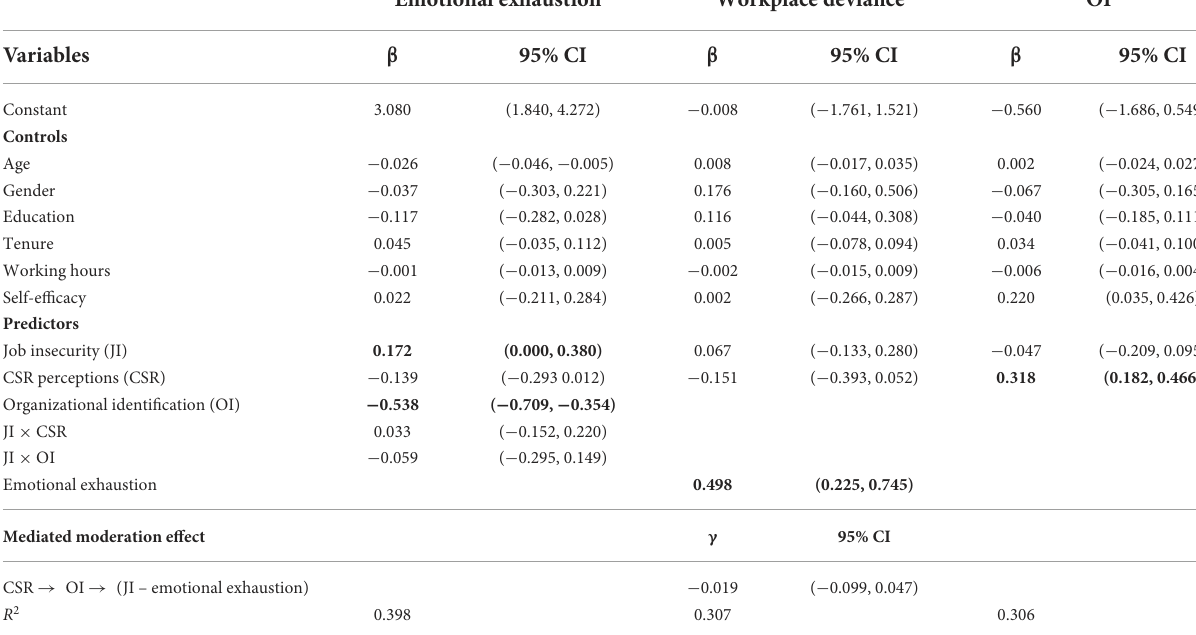
TABLE 5 Supplement analysis 1: results of unidimensional construct of job insecurity. Emotional exhaustion